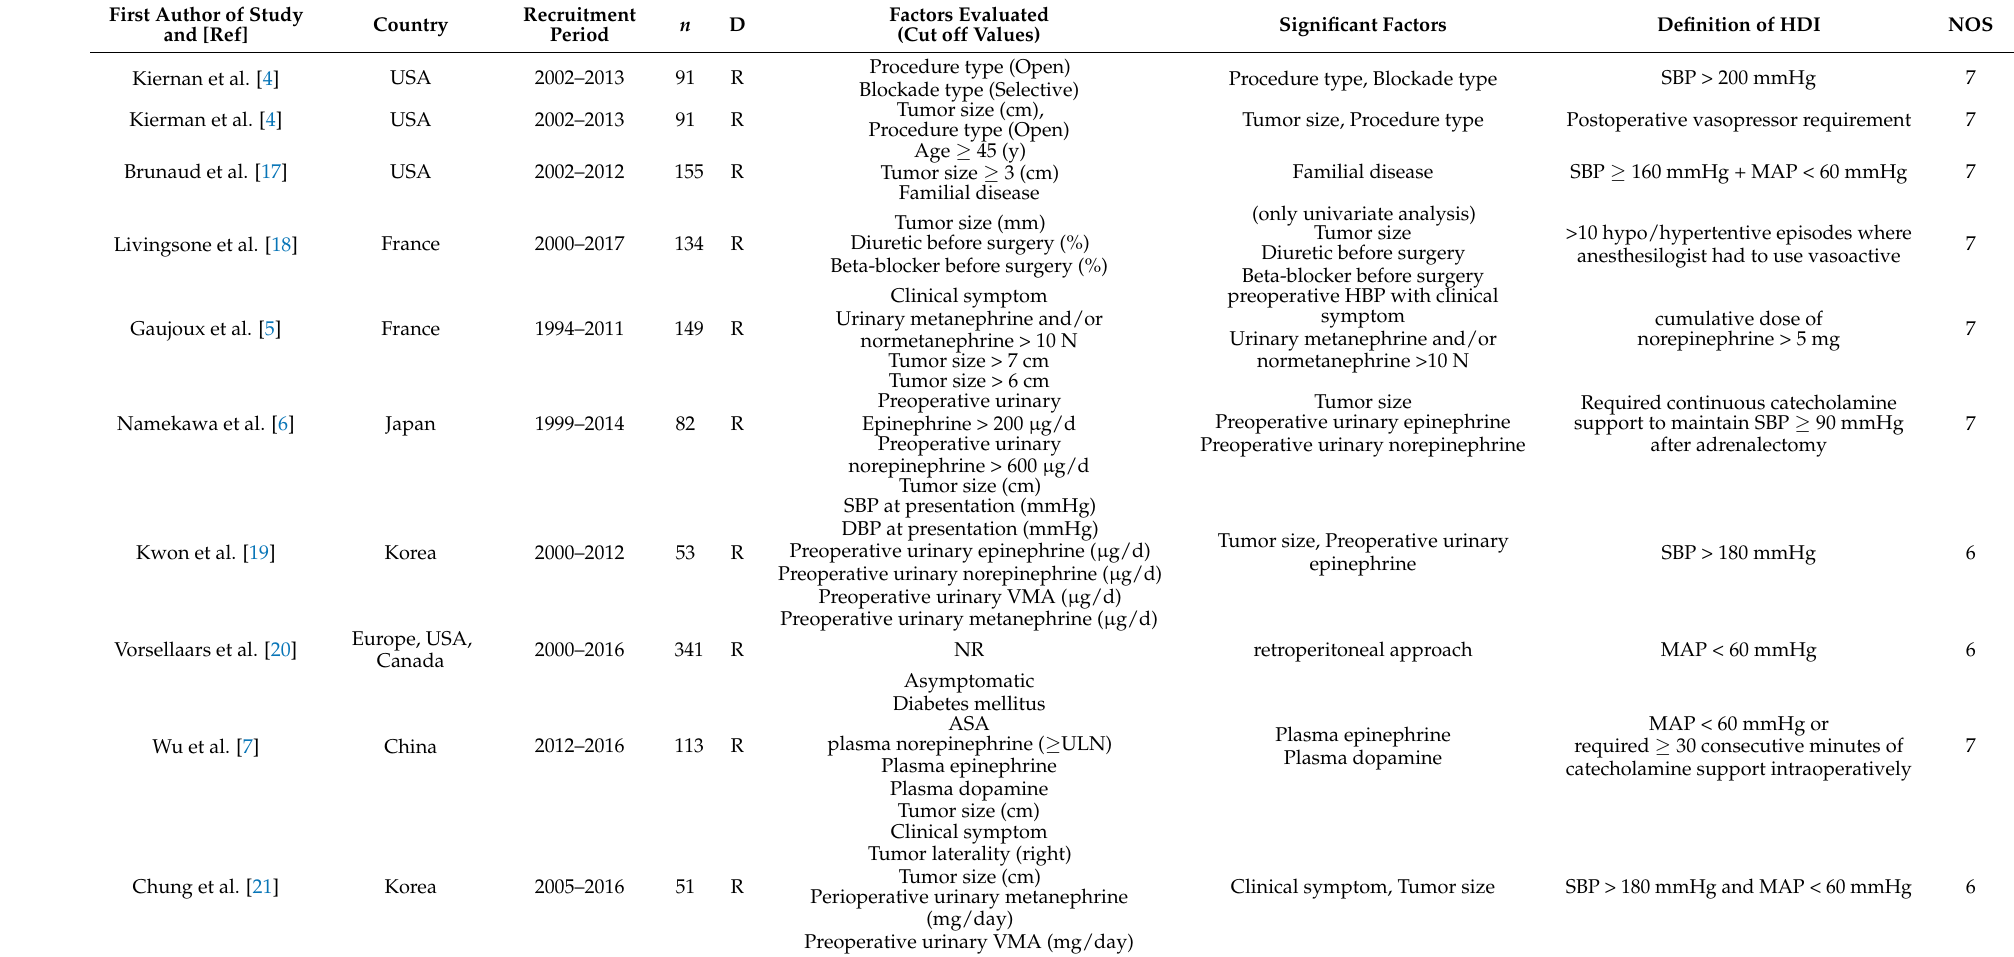
Table 1. The Studies’ Characteristics of All Included